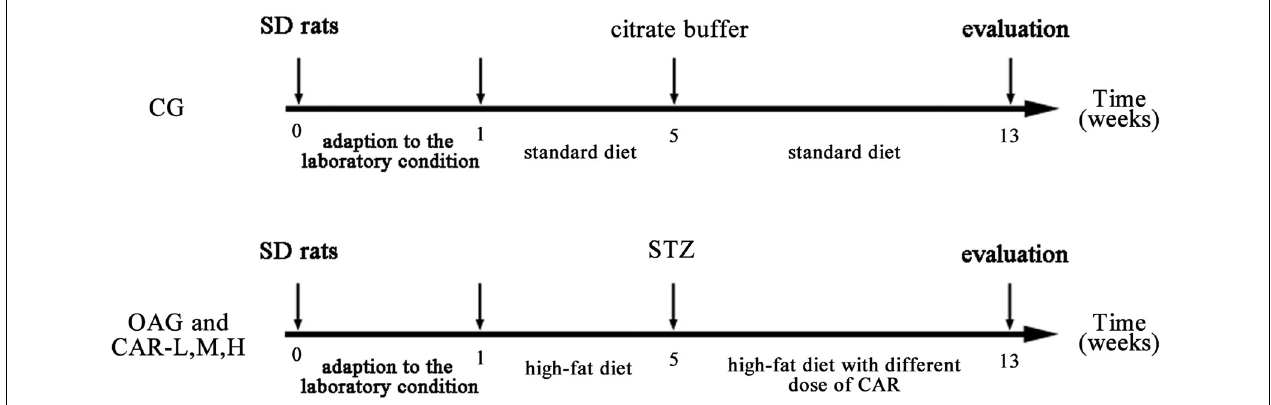
FIGURE 1 | Treatment schedule and intervals for various